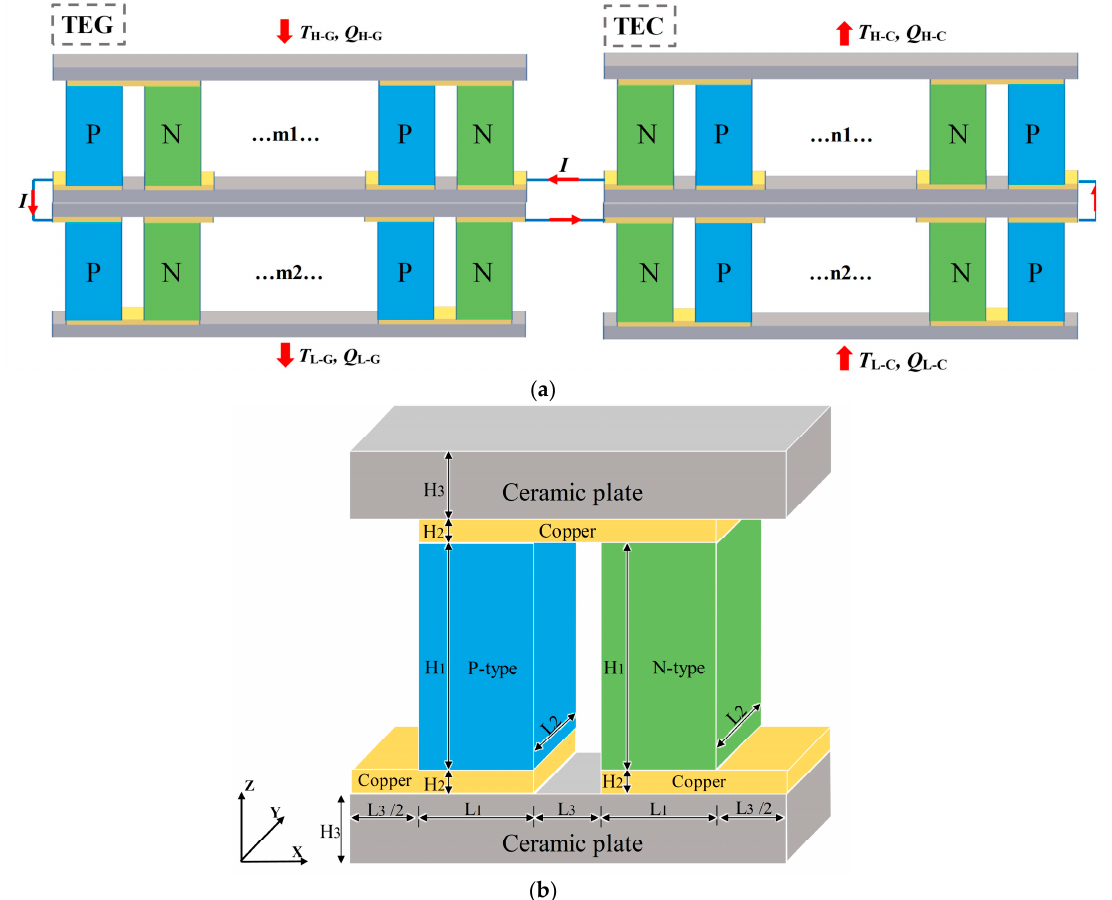
Figure 1. ( a ) Schematic diagram of the two-stage CTE; ( b ) Schematic diagram thermoelectric element of the CTE. Table 2. Geometry structure of thermoelectric